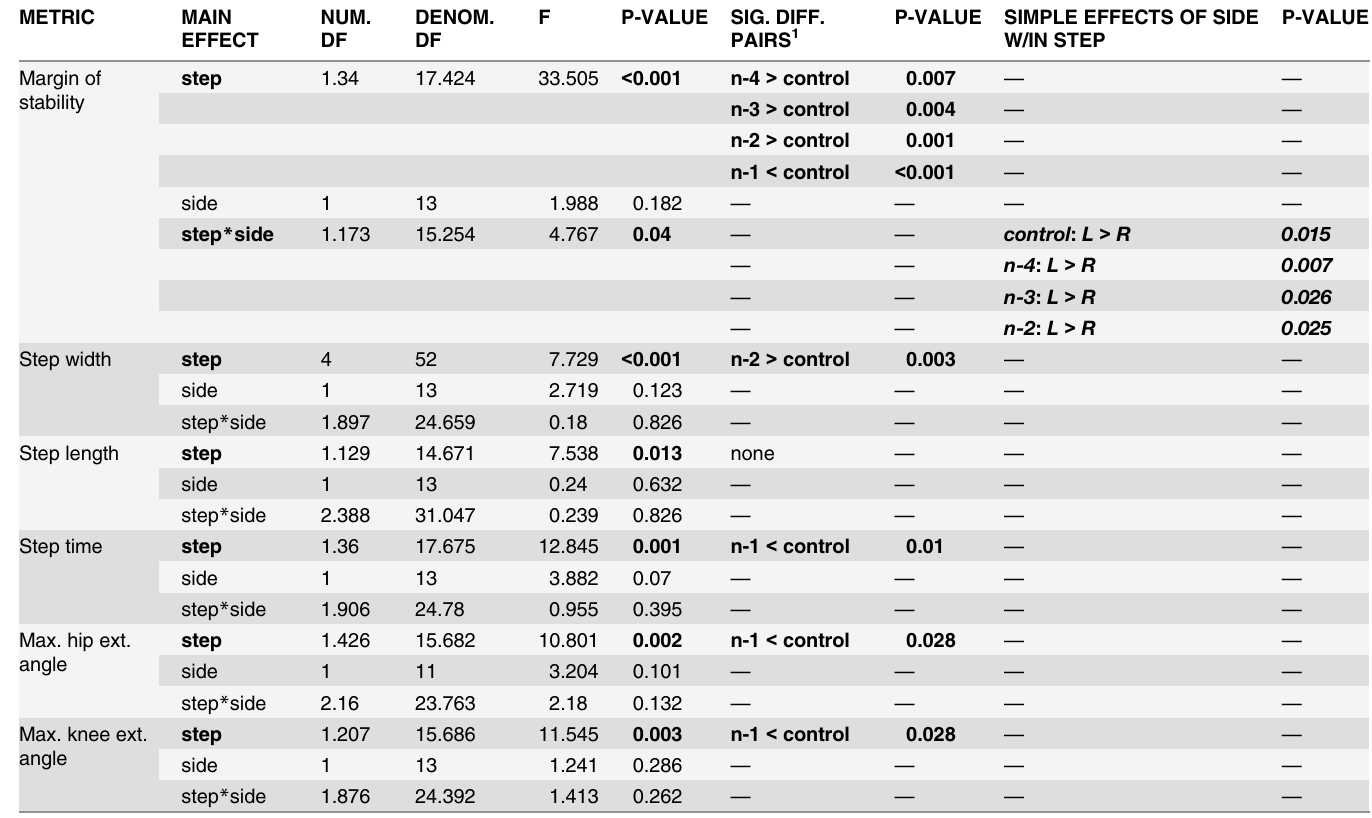
Table 2. Known target direction statistical